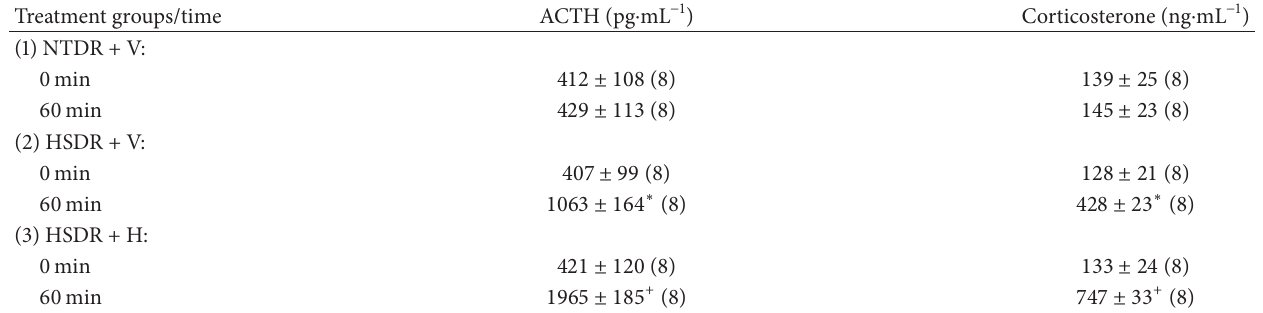
Table 3: The plasma levels of both adrenocorticotrophic-hormone (ACTH) and corticosterone for (NTDR + V) rats, (HSDR + V) rats, and (HSDR + H) rats.